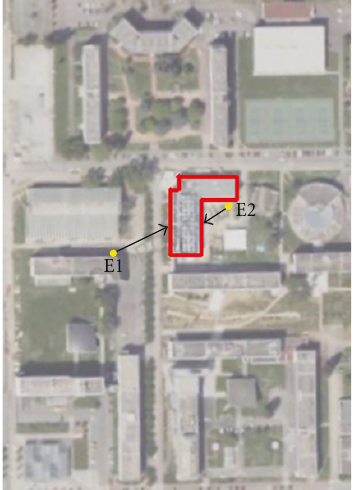
Figure 2: Outdoor to indoor scenario. In red: the building where the indoor measurements were performed. E1 and E2 represent the position of each emitter and the black arrows show the directions where the directive antennas were